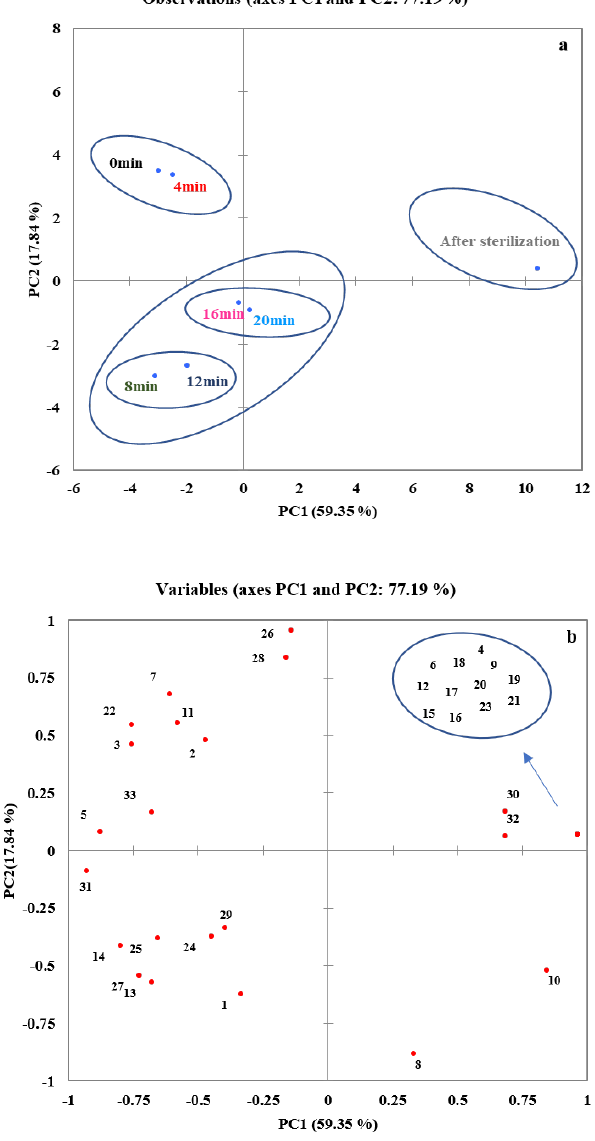
Figure 6. Analysis score (a) and correlation loading (b) plot of principal components 1 and 2 for the volatile compounds in coconut jam. Coconut jam sample distribution at different concentration times (a). Distribution of 33 volatile compounds in coconut samples (b).